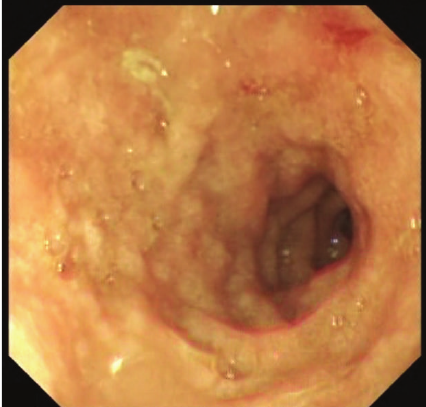
Figure 2: Duodenal bulb showing edematous nodular mucosa with erythematous spot.